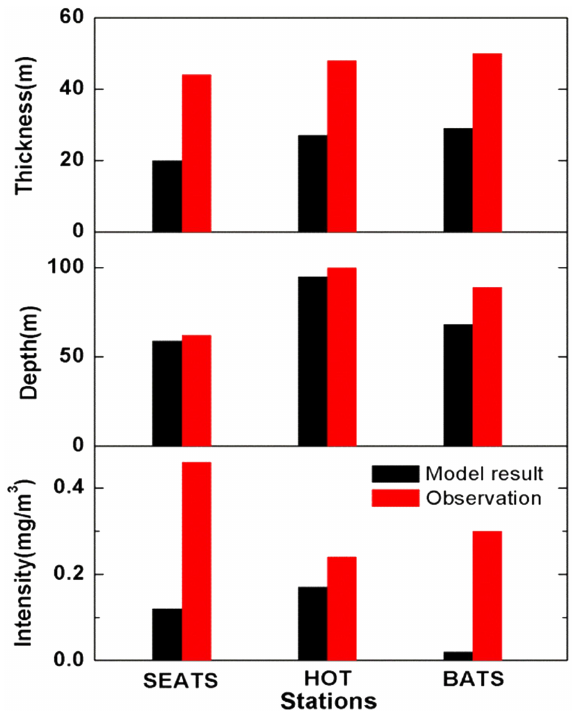
Figure 2. Comparisons of the model results and observations (in terms of thickness, depth, and intensity of SCML) at SEATS, HOT, and BATS (black columns represent the model results and red columns are the observations at the three stations which were fitted via a Gaussian function using annually averaged data obtained from http://www.odb.ntu.edu.tw/, http://hahana.soest. hawaii.edu/hot/hot-dogs/cextraction.html, and http://bats.bios.edu/,